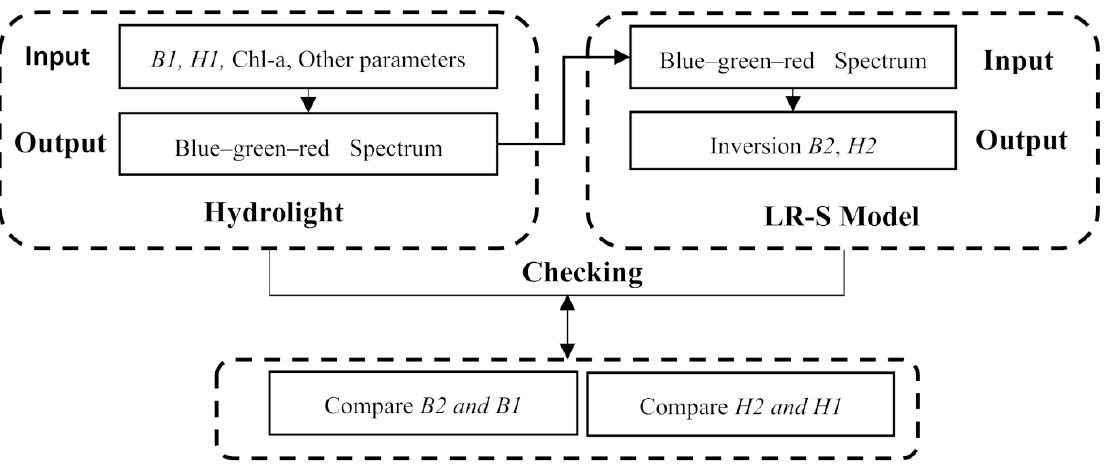
Figure 2. Checking workflow using simulation dataset and the LR-S model.